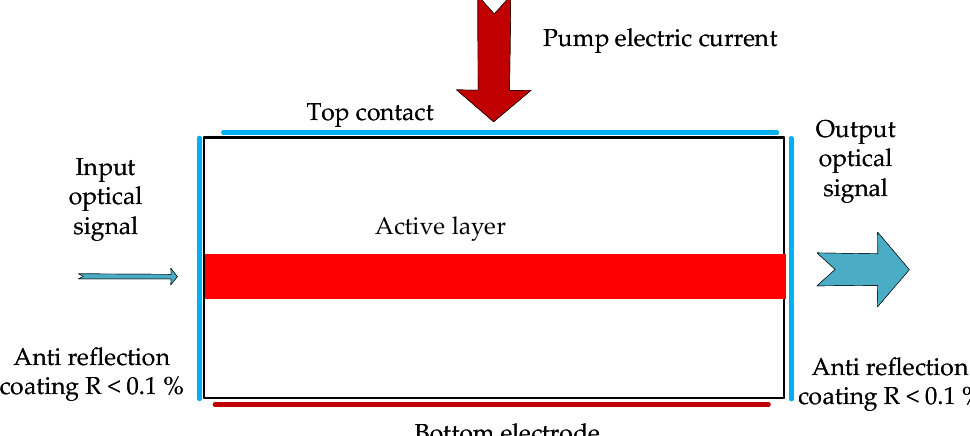
Figure 8. Schematic diagram of a semiconductor optical amplifier